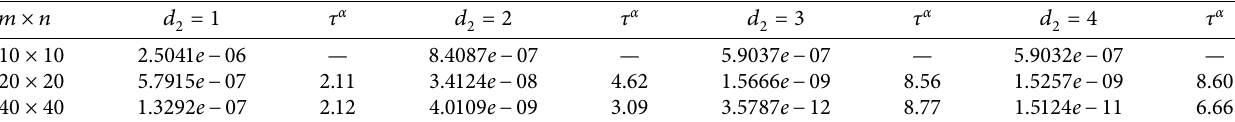
� 9 for Example 1. 1